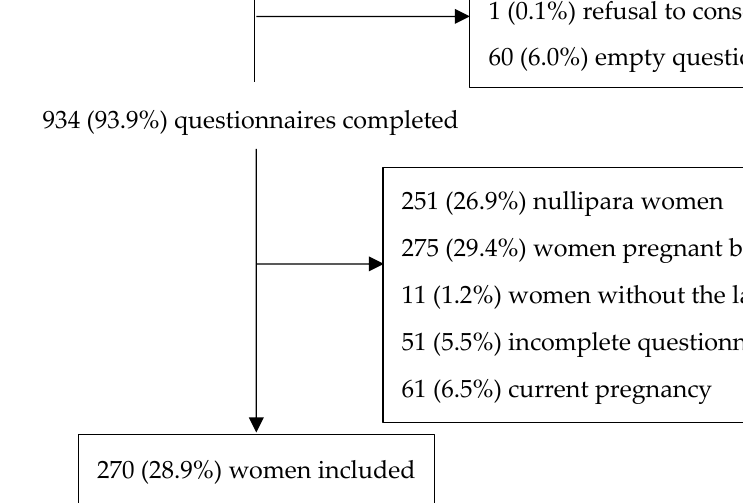
Figure 1. Flow chart of a cross-sectional electronic survey of female physicians working in a French region.